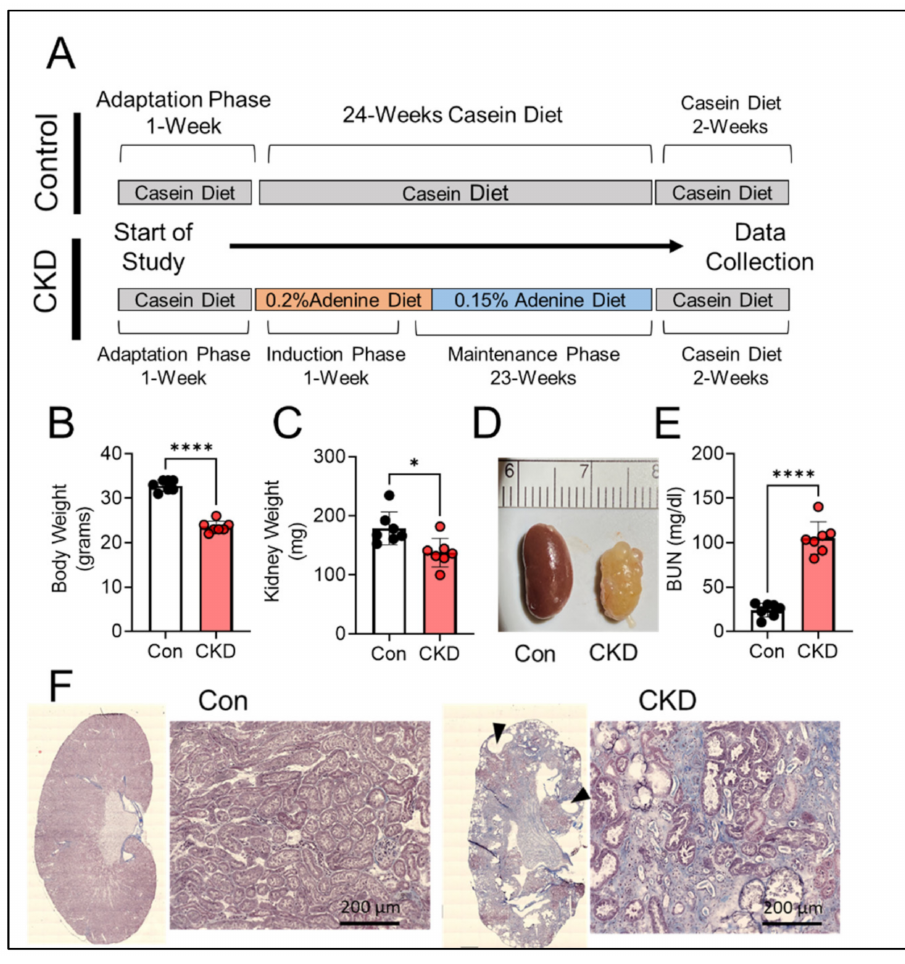
Figure 2. Chronic adenine feeding in mice causes significant kidney pathology. ( A ) Experimen- tal design for diet manipulation for induction of CKD and timing of relevant outcome measures. ( B ) Quantification of body weights in control and CKD mice ( n = 7/group); ( C ) Quantification of kidney weights of Con vs. CKD mice ( n = 7/group). ( D ) Representative image of a control and CKD mouse kidney. ( E ) Blood urea nitrogen concentration in the plasma of control and CKD mice measured after 6 months of diet ( n = 7/group). ( F ) Representative histological image of Masson’s trichrome staining of control and CKD kidney (black triangles identify cyst like structures). Data were analyzed using two-tailed unpaired t -test. Error bars show standard deviation. p < 0.05 * and p < 0.0001